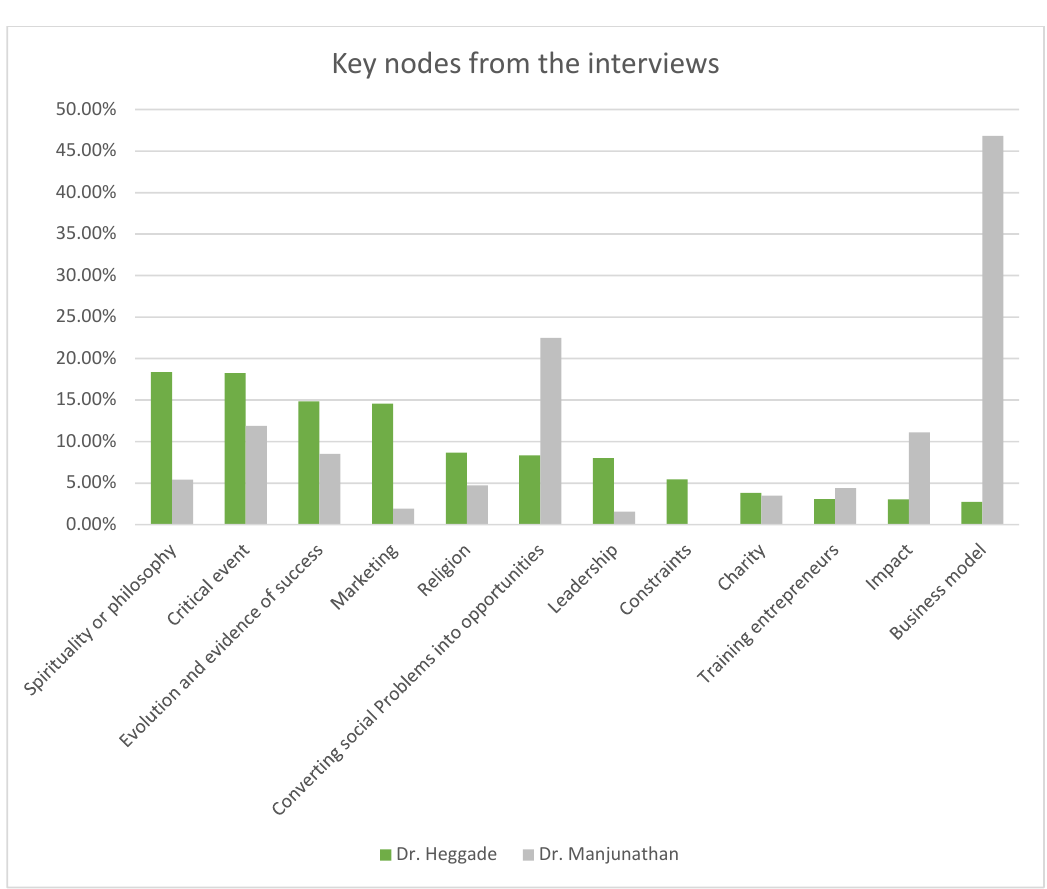
Figure 2. Discourse analysis of the two interviews: different coverage.